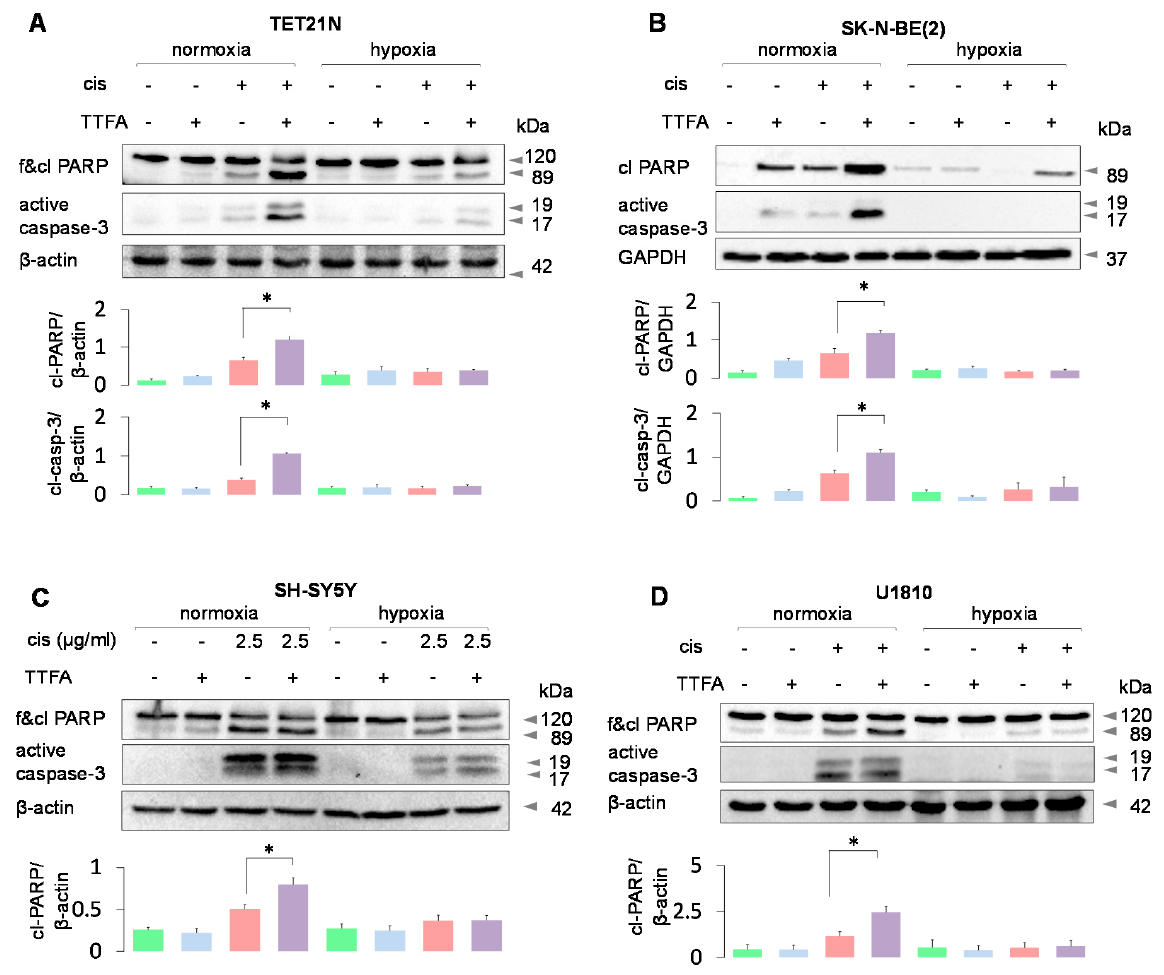
Figure 1. Hypoxia suppresses cell death induced by cisplatin in the presence or absence of TTFA, an inhibitor of Complex II of the mitochondrial respiratory chain. Assessment of apoptotic manifestations in Tet21N ( A ), SK-N-BE(2) ( B ), SH-SY5Y neuroblastoma cells ( C ), and lung large cell carcinoma U1810 cells( D ). Bars under blots show quantification of Western blot data based on three independent experiments. * p < 0.01.